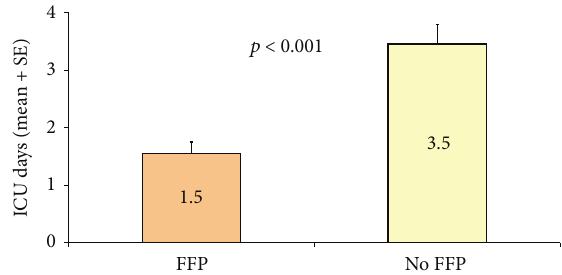
Figure 2: ICU stays differed significantly by group. FFP, fresh frozen plasma; ICU, intensive care unit; SE, standard error.